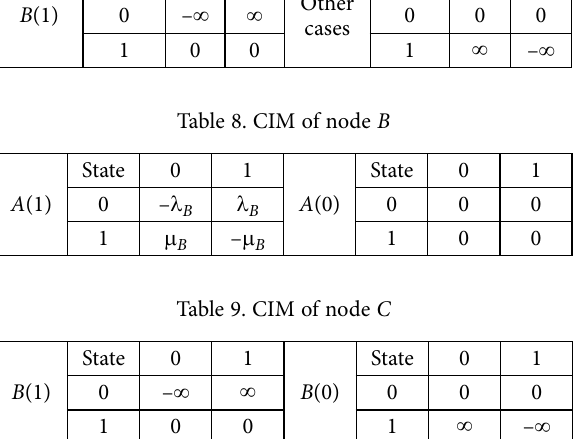
Figure 4. SEQ gate and its corresponding CTBN representation